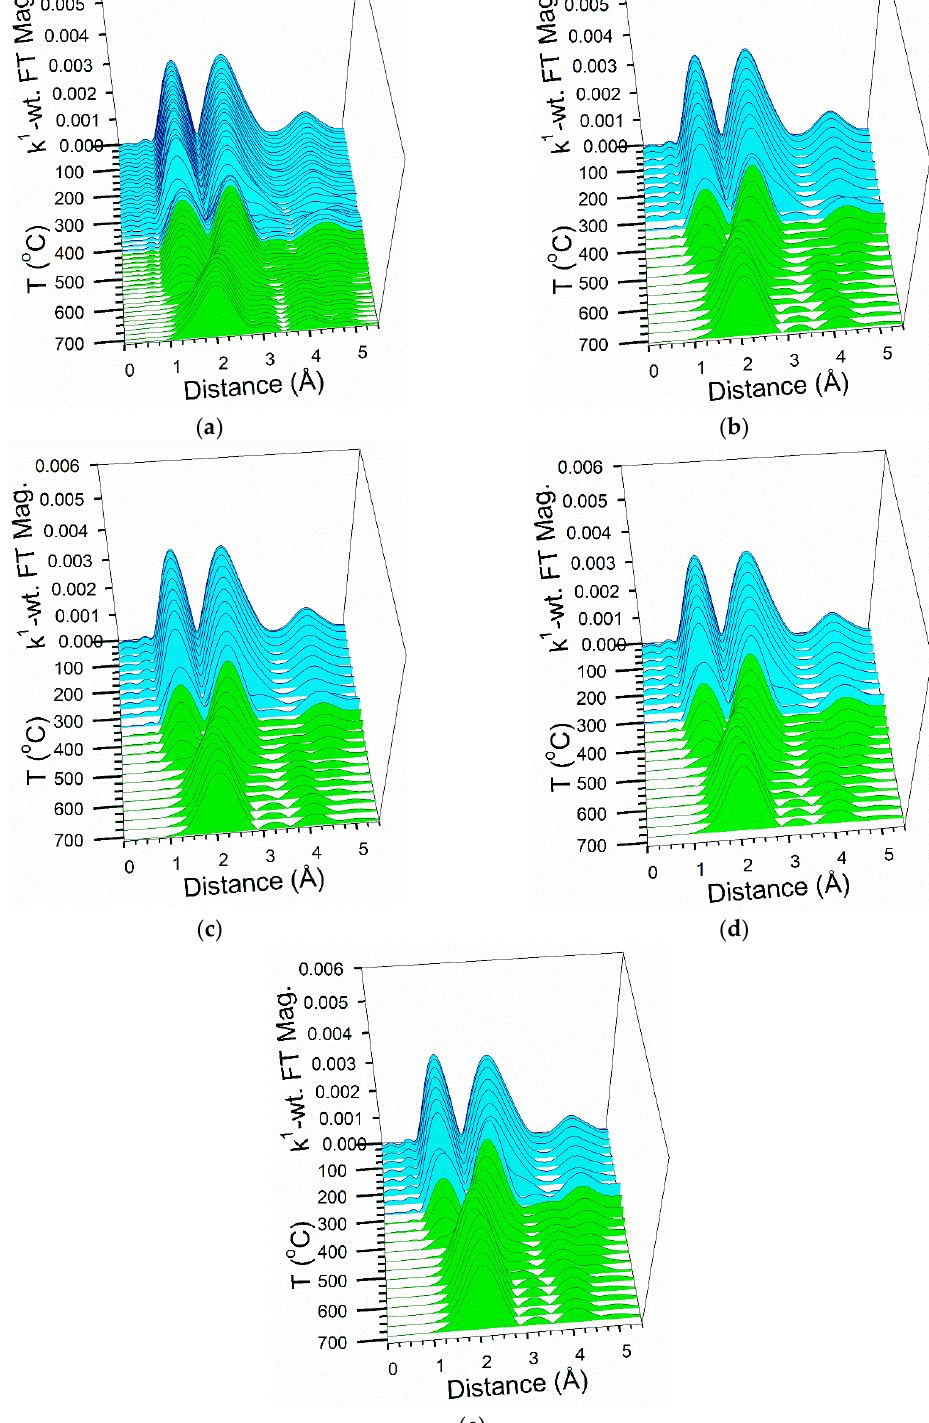
Figure 8. H 2 -TPR-EXAFS spectra at the Co K-edge of ( a ) 25%Co/Al 2 O 3 , ( b ) 25%M (M = 5%Ni-95%Co)/Al 2 O 3 , ( c ) 25%M (M = 10%Ni-90%Co)/Al 2 O 3 , ( d ) 25%M (M = 25%Ni-75%Co)/Al 2 O 3 , and ( e ) 25%M (M = 50%Ni-50%Co)/Al 2 O 3 . (Cyan) is reduction of Co 3 O 4 to CoO, and (Green) CoO to Co 0 .